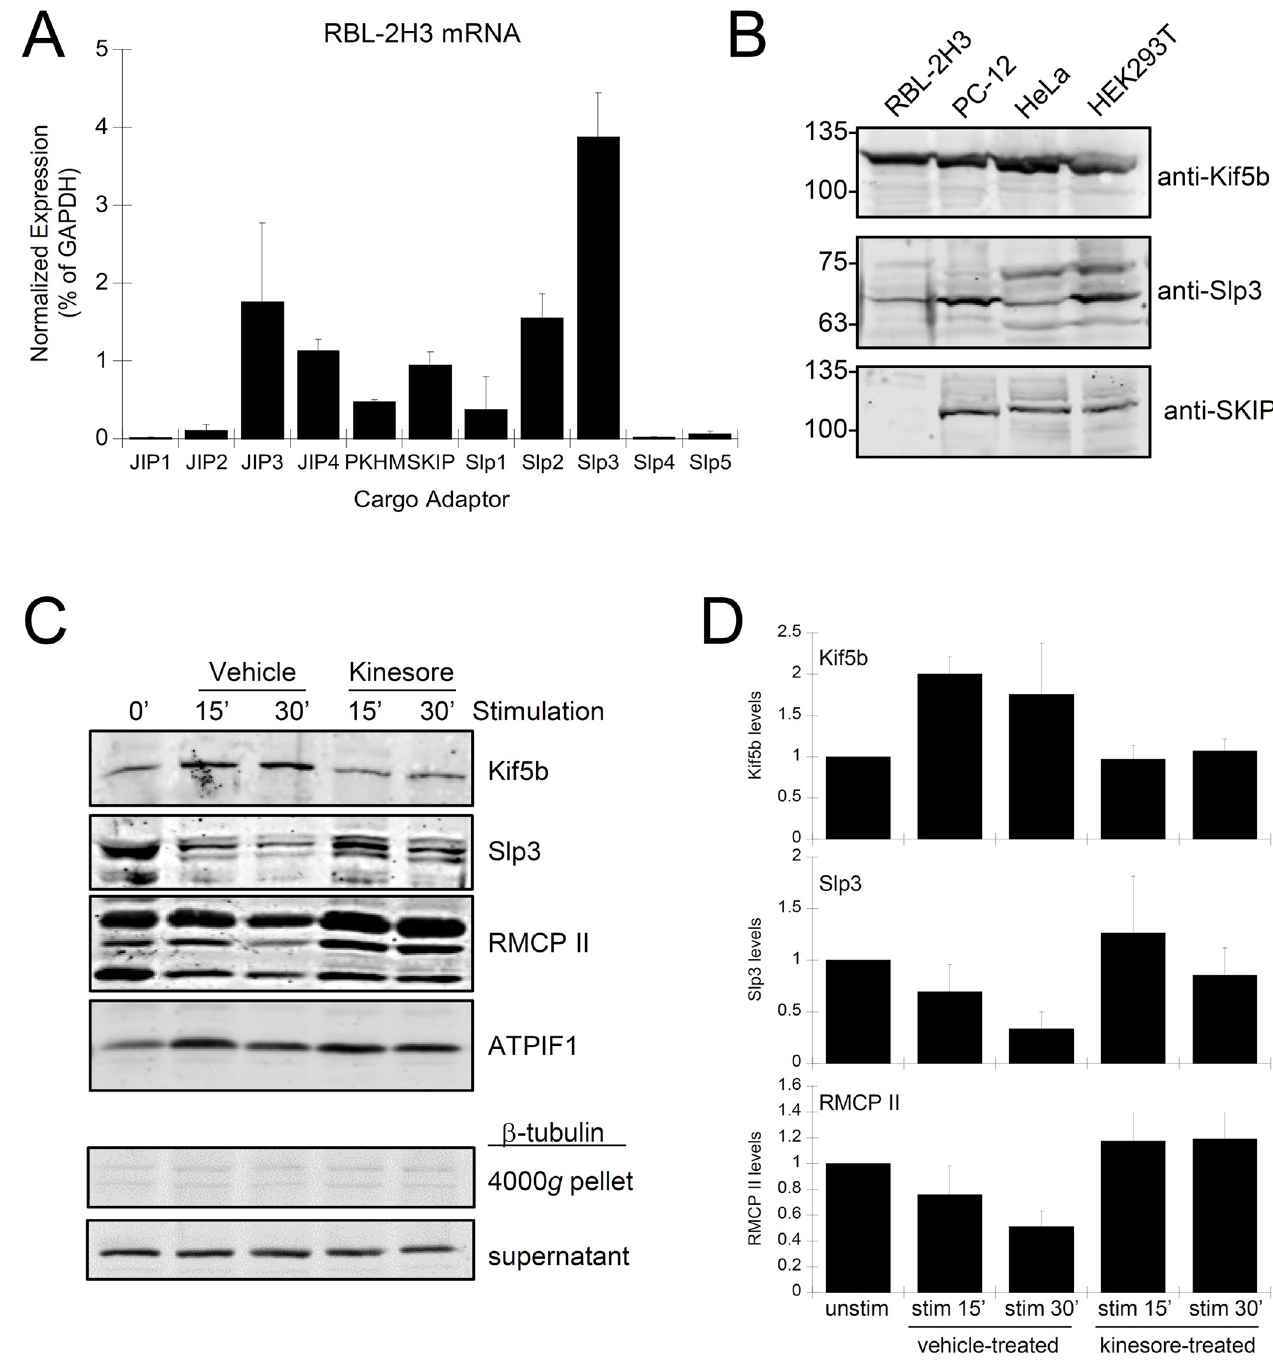
Fig 7. Kinesore inhibits granule association of the microtubule motor kinesin-1. A) Quantitative PCR analysis of mRNA isolated from RBL-2H3 cells. Gene expression level of cargo adaptors known to associate with secretory granules and lysosomes. B) Immunoblot of lysates from RBL-2H3, PC-12, HeLa and HEK293T cells (10 7 cells/ml lysate). Lysates were probed for Kif5b, and two cargo adaptors, Slp3 and SKIP. SKIP was not detected in RBL-2H3 cells. C) Granule-enriched fractions were prepared by differential centrifugation from unstimulated cells ( 0’ ), or from cells that were antigen-stimulated for 15 min and 30 min in the presence of kinesore or vehicle (0.5% DMSO). Fractions were probed by immunoblot for association of the microtubule motor subunit Kif5b, the cargo adaptor Slp3, the granule enzyme rat mast cell protease II (RMCP II) and the mitochondrial marker ATPIF1 ( upper panels ). Tubulin was not associated with the granule enriched fraction and instead was found in supernatant ( lower panels ). D) Levels of protein associated with granule-enriched fractions were examined by band densitometry of immunoblots. Values were normalized to unstimulated cells for each experiment (n = 3).